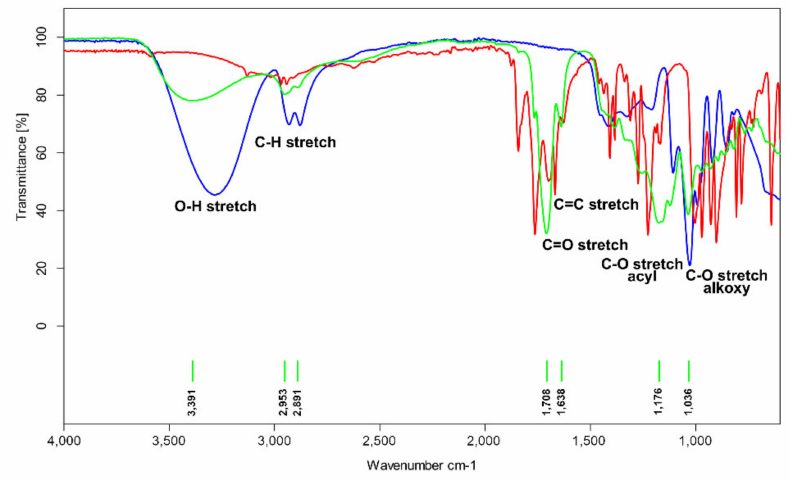
Figure 7. FTIR spectra of poly(glycerol itaconate) (green), itaconic anhydride (red), and glycerol (blue).